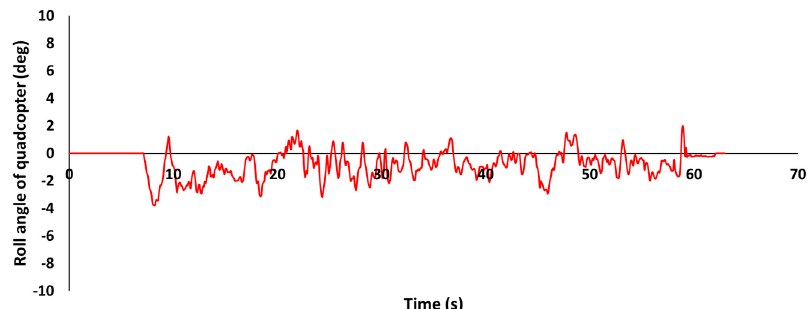
Figure 32. Roll angle of the quadcopter during the vertical takeoff and landing.